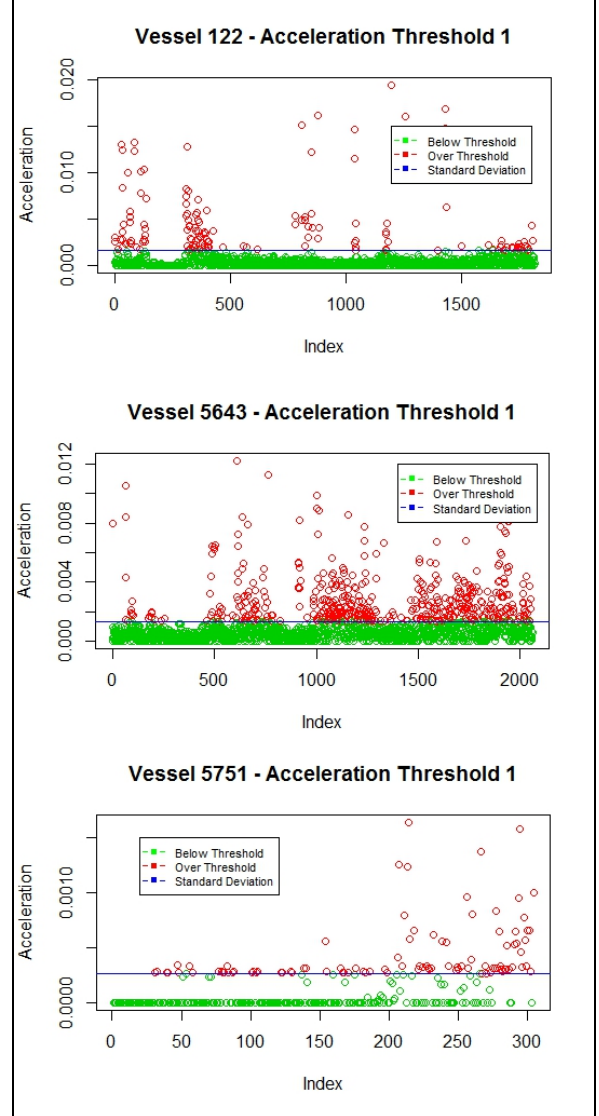
Figure 3 . Acceleration Threshold